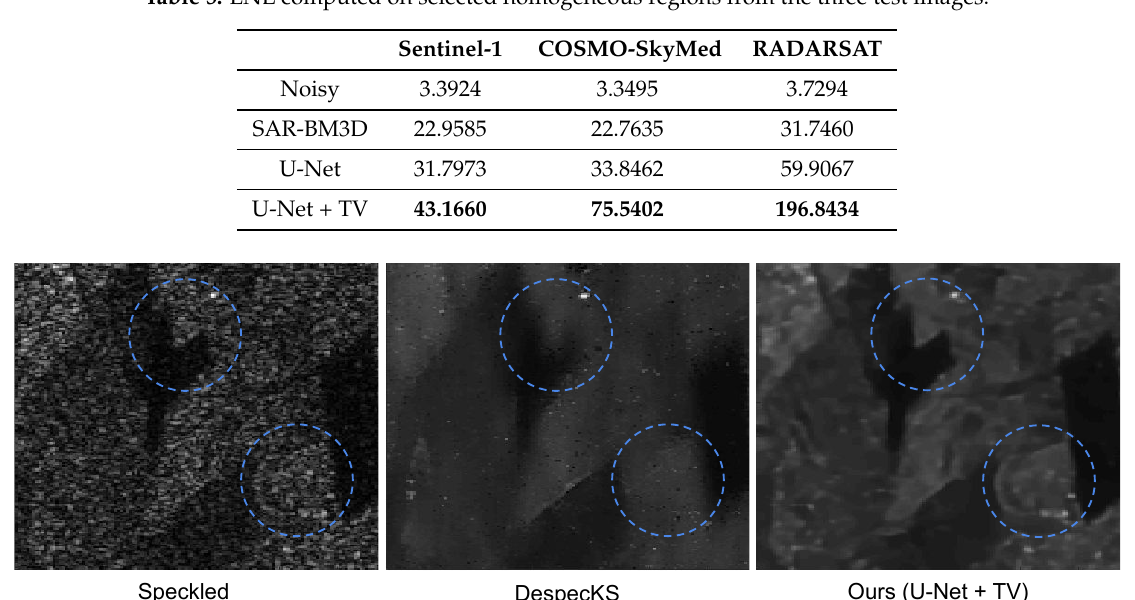
Table 5. ENL computed on selected homogeneous regions from the three test images.